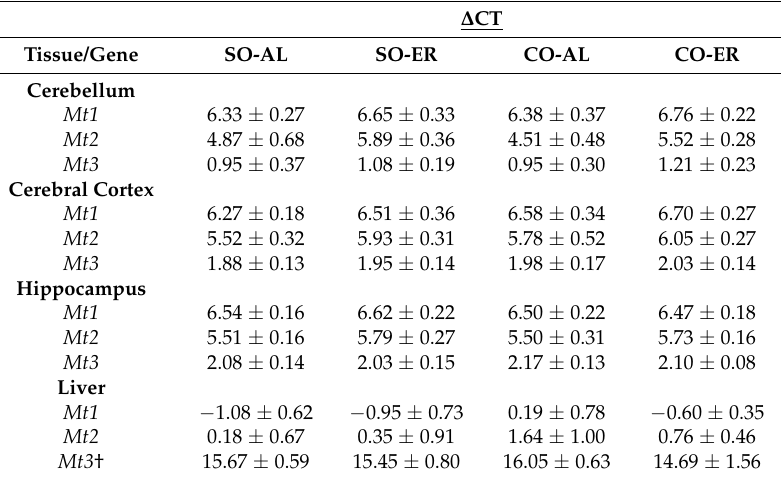
Table A2. ∆ Ct values for Mt1-3.